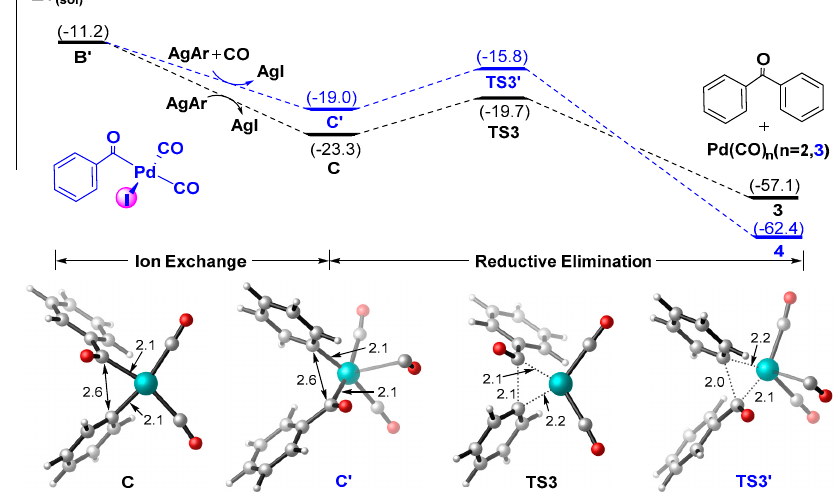
Figure 2. Reaction potential surfaces for the formation of ketones derived from aromatic silver.